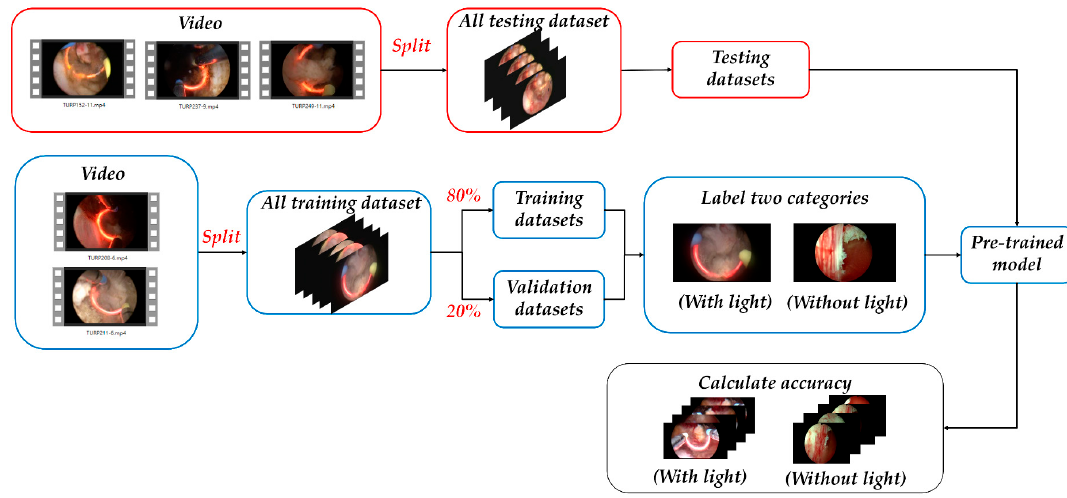
Figure 3. The flowchart of the ResNet-50 model.